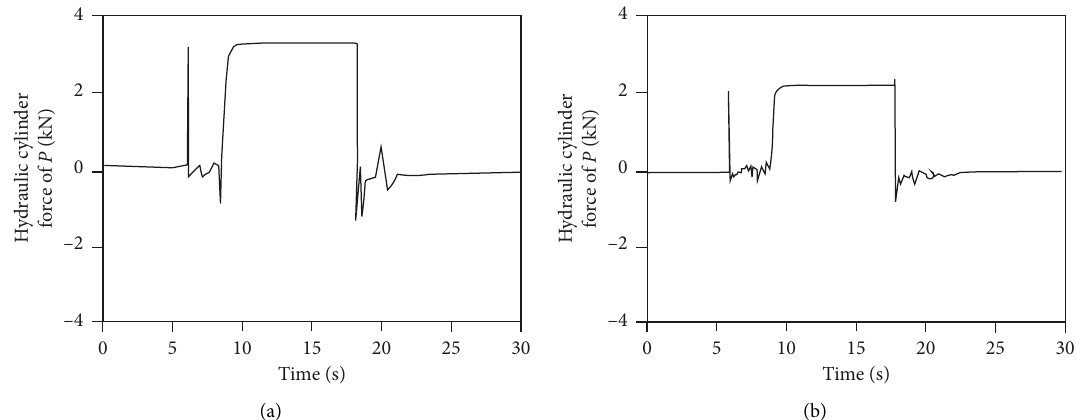
Figure 8: Hydraulic cylinder two chamber pressure and output force curves. (a) Direct switching control. (b) Fuzzy switching